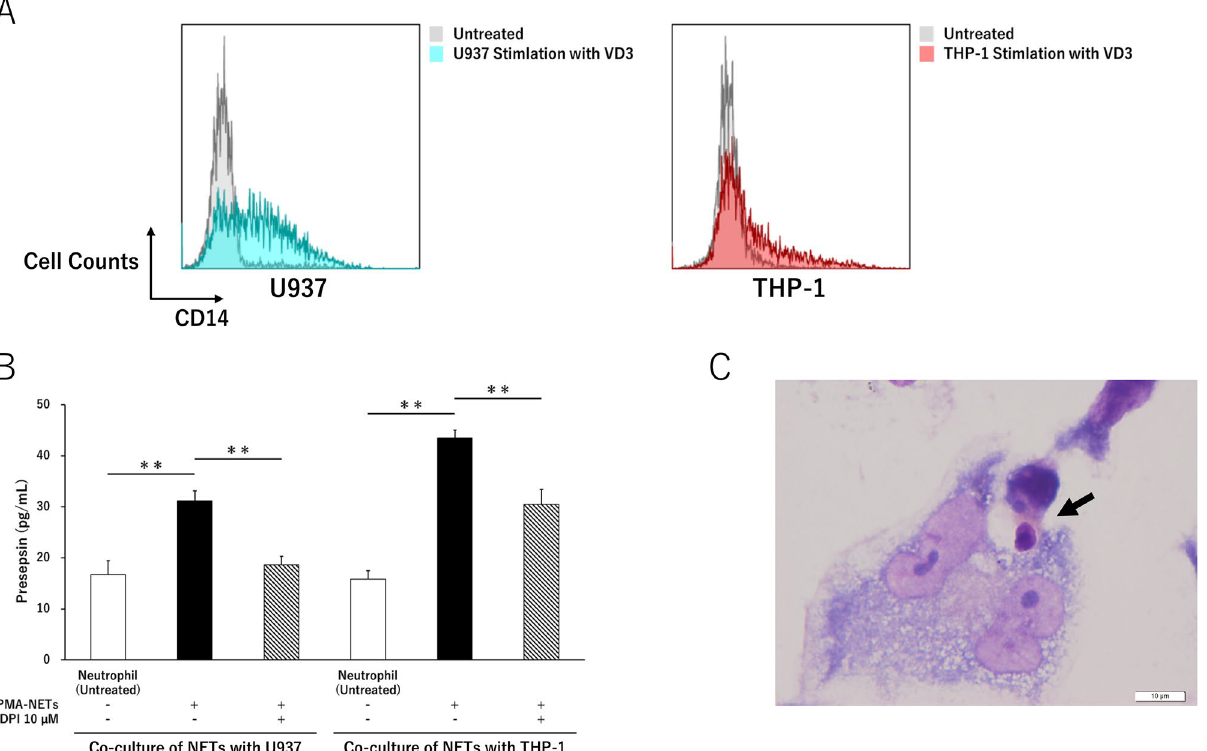
Figure 6. Presepsin levels increase as macrophages phagocytose NETs and decrease when NETs are suppressed. ( A ) Differentiation into macrophages used VD3 to induce CD14 expression against U937 and THP-1 cell lines. ( B ) Comparison of presepsin levels when co-cultured with PMA-NETs and macrophages. ( C ) Phagocytosis of PMA-NETs by THP-1 after macrophage induction visualized May–Giemsa staining. Scale bar: 10 μm. ** p < 0.001, compared with untreated neutrophils. Data represent the mean values ± SD of at least three